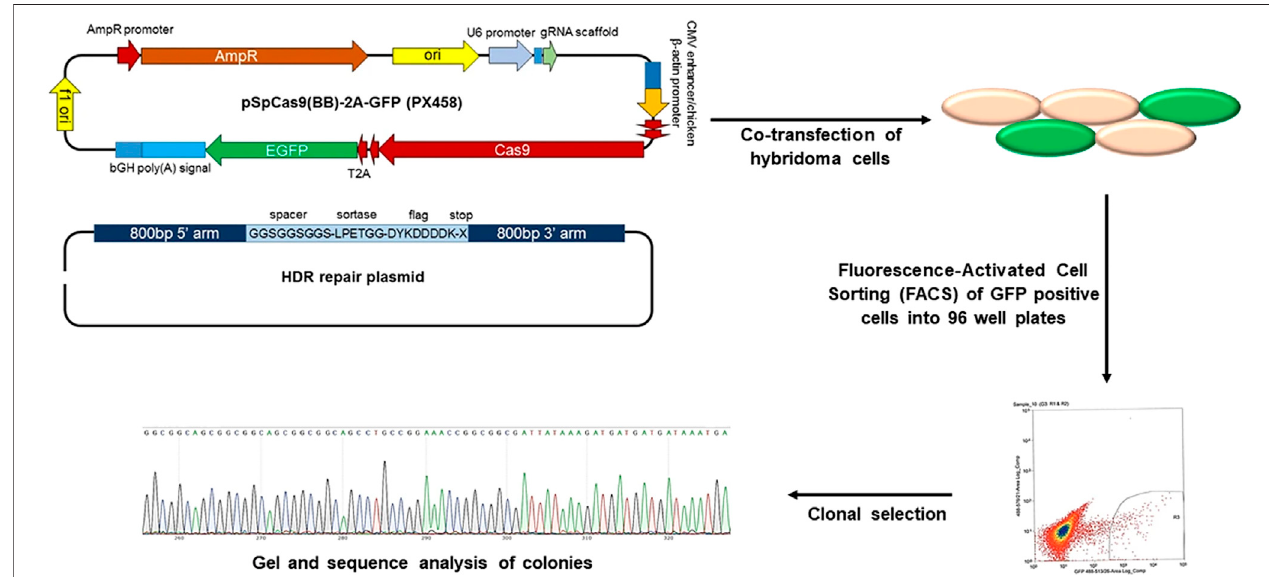
FIGURE 6 | CRISPR/Cas9 genome editing of hybridoma cells for site-speci fi c modi fi cation (Reproduced from Khoshnejad et al., 2018).